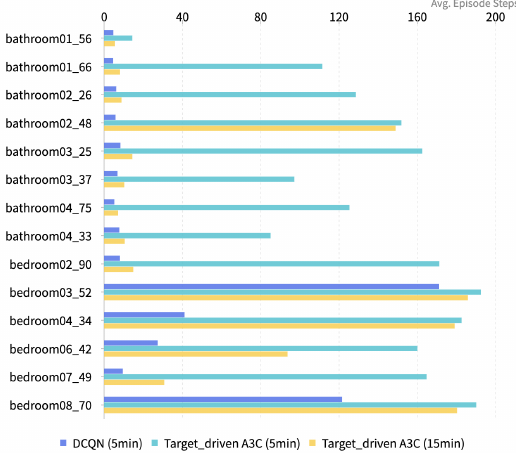
Figure 10. Comparison of the DCQN agent with Target-driven AC